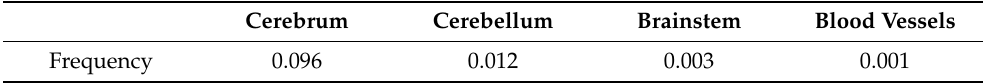
Table 2. Frequency of the foreground classes in the training subset ( n = 60).